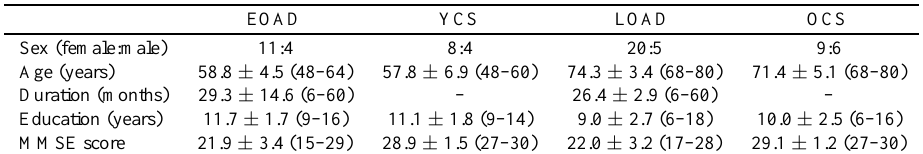
Table 1 Demographic variables of patients and control subjects